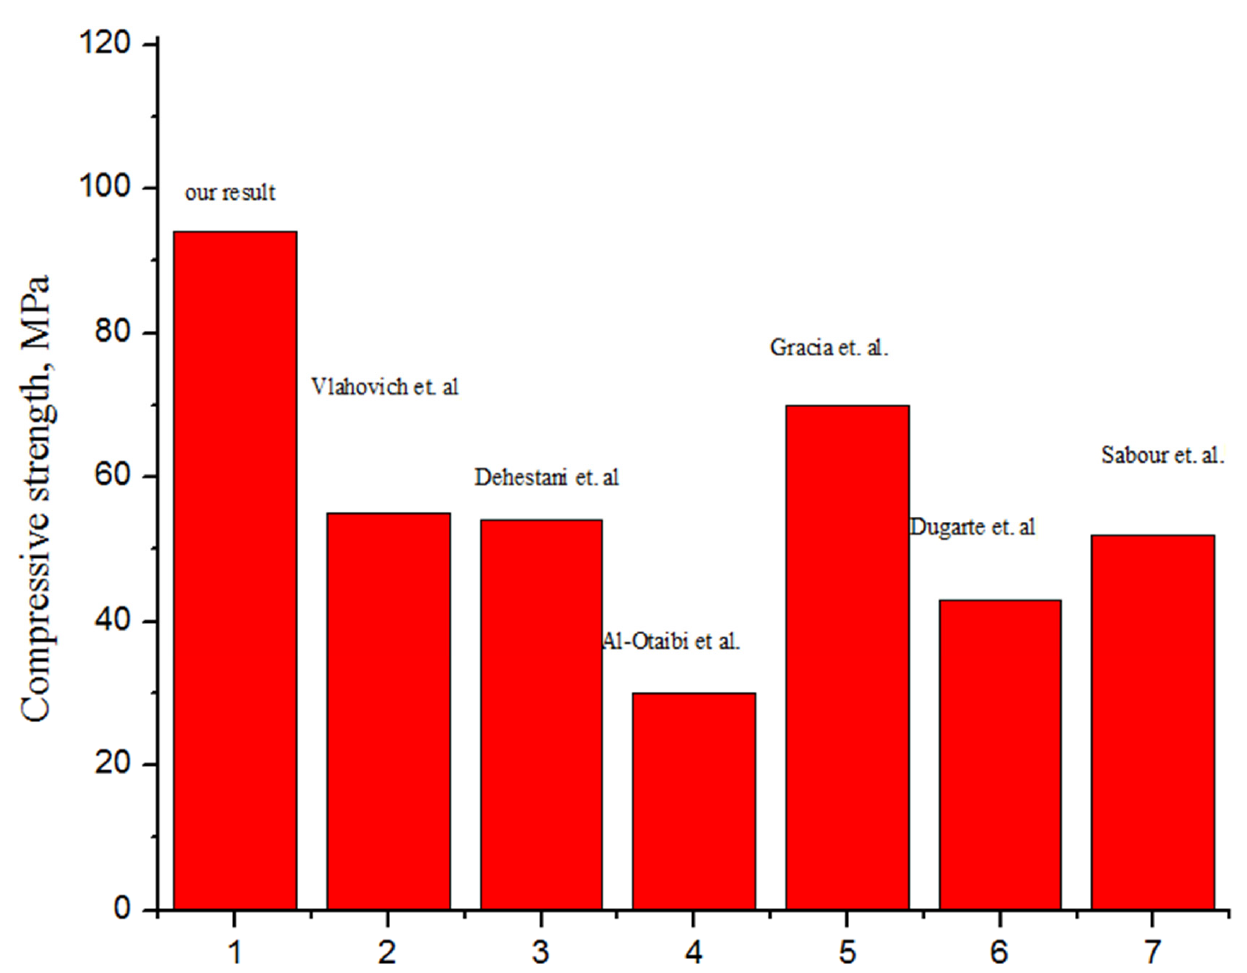
Figure 8. Comparison of the obtained results and literature data (single-column fitting image) [5,19,25,31–33].